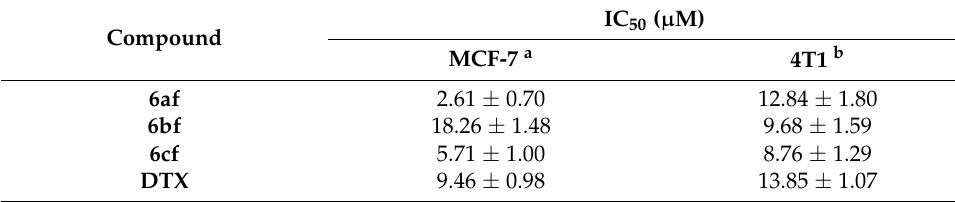
Table 3. IC 50 ( µ M) values of the active compounds in two different cancer cell lines.